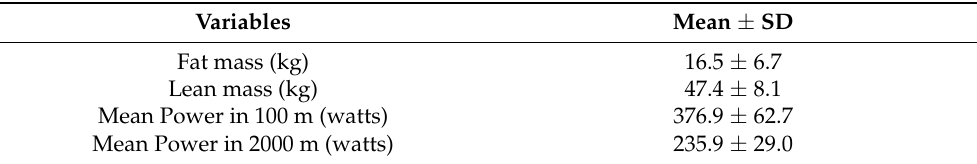
Table 1. Subject